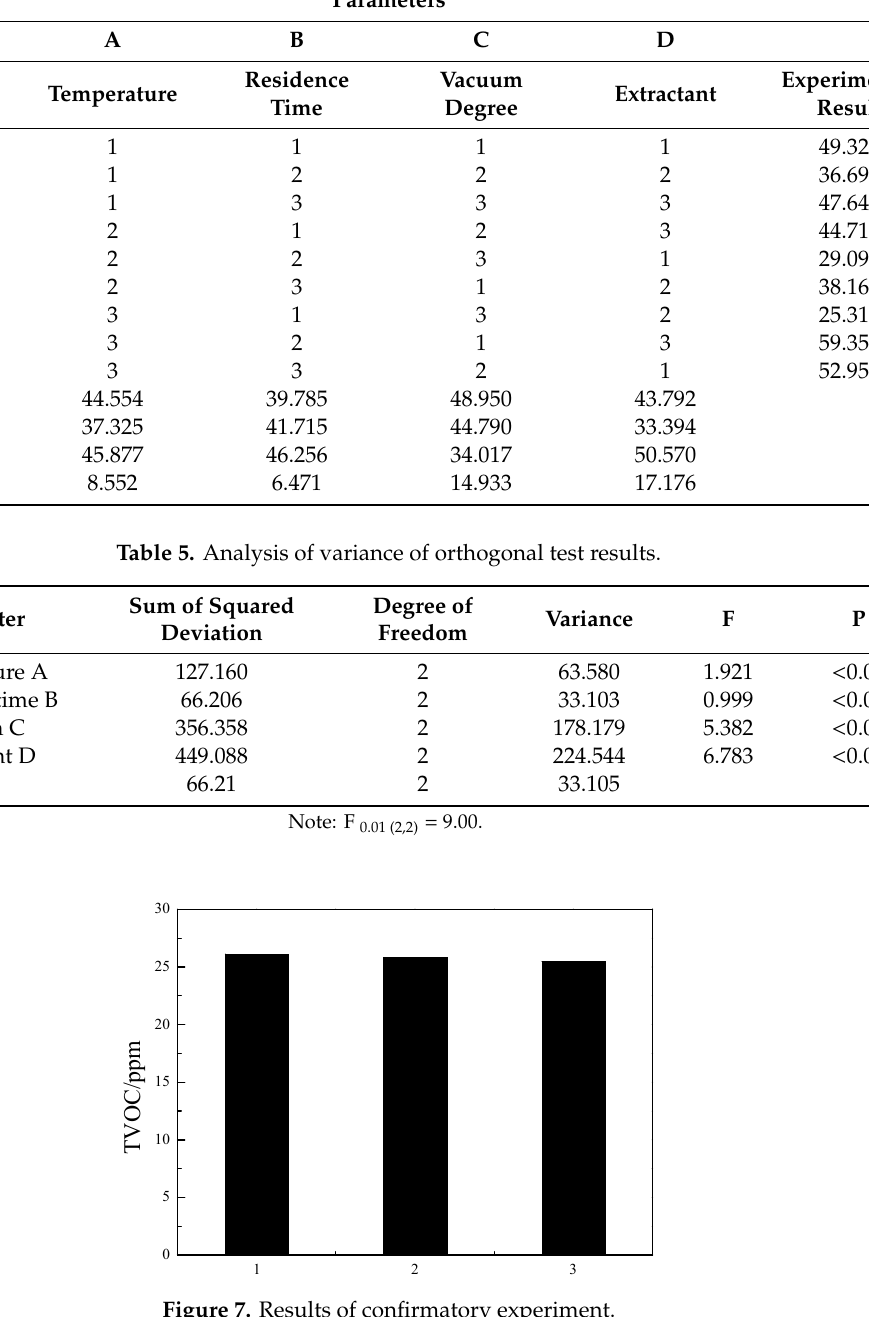
Table 4. Process orthogonal test analysis results.